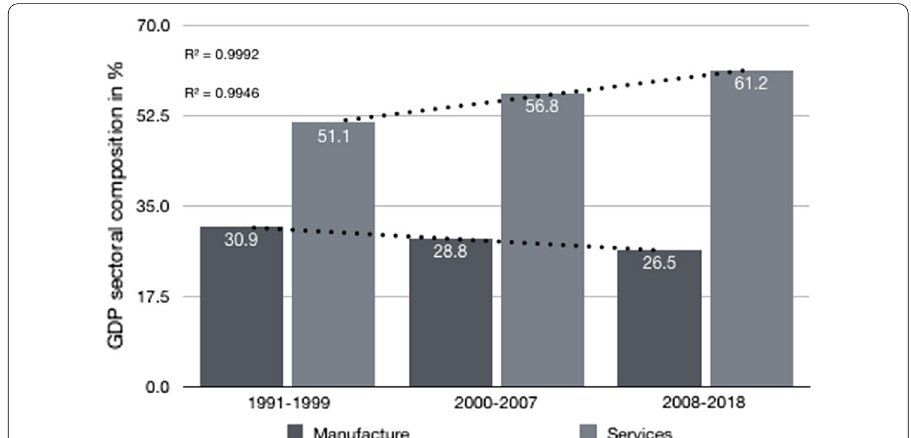
Fig. 2 Changes in the GDP sectoral composition in selected periods (source: Central Bank of the Dominican Republic